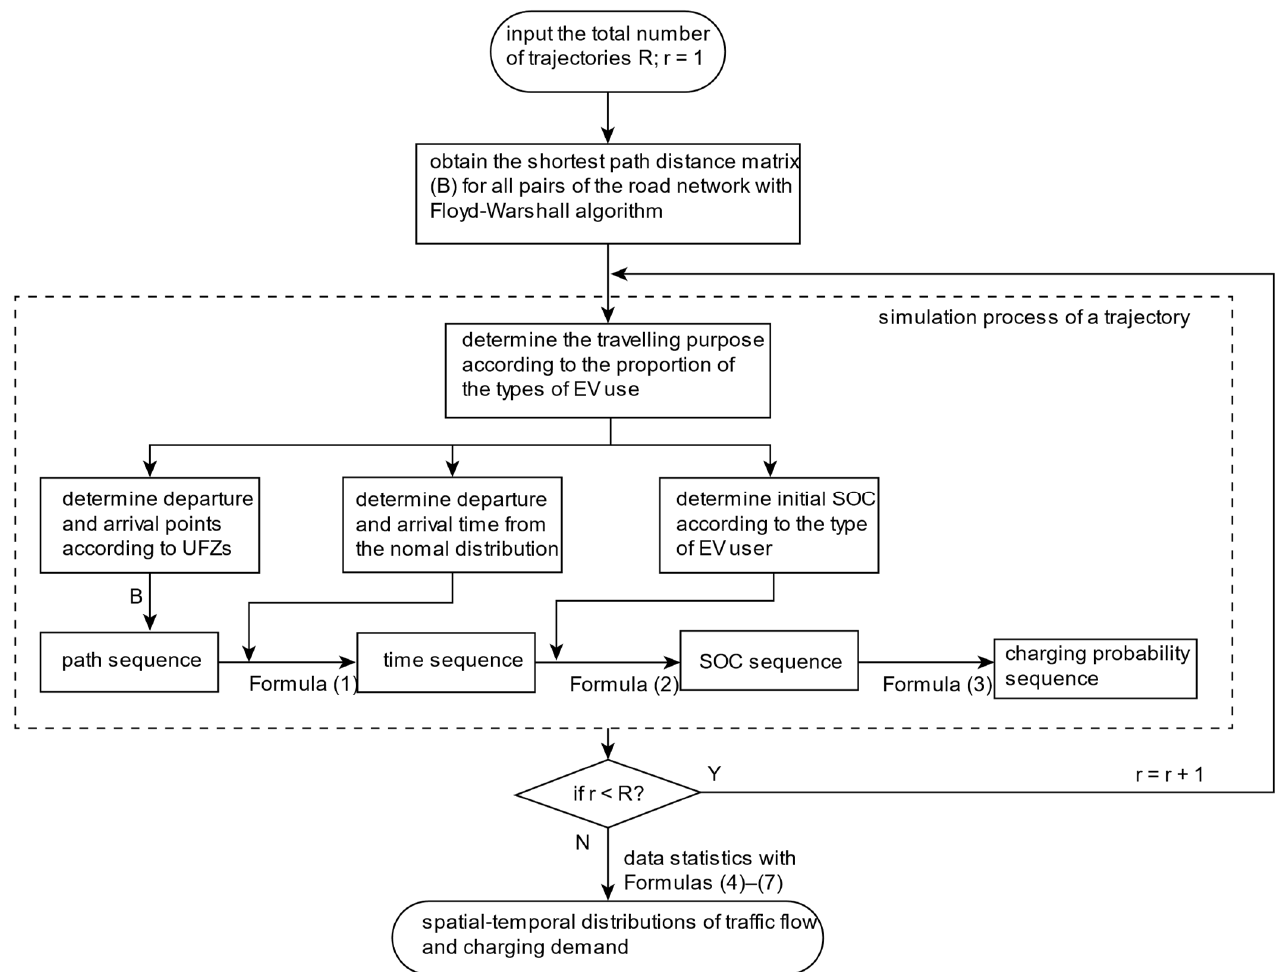
Figure 2. Flow chart of simulating spatial-temporal distributions of traffic flow and charging demand based on the Monte Carlo method.